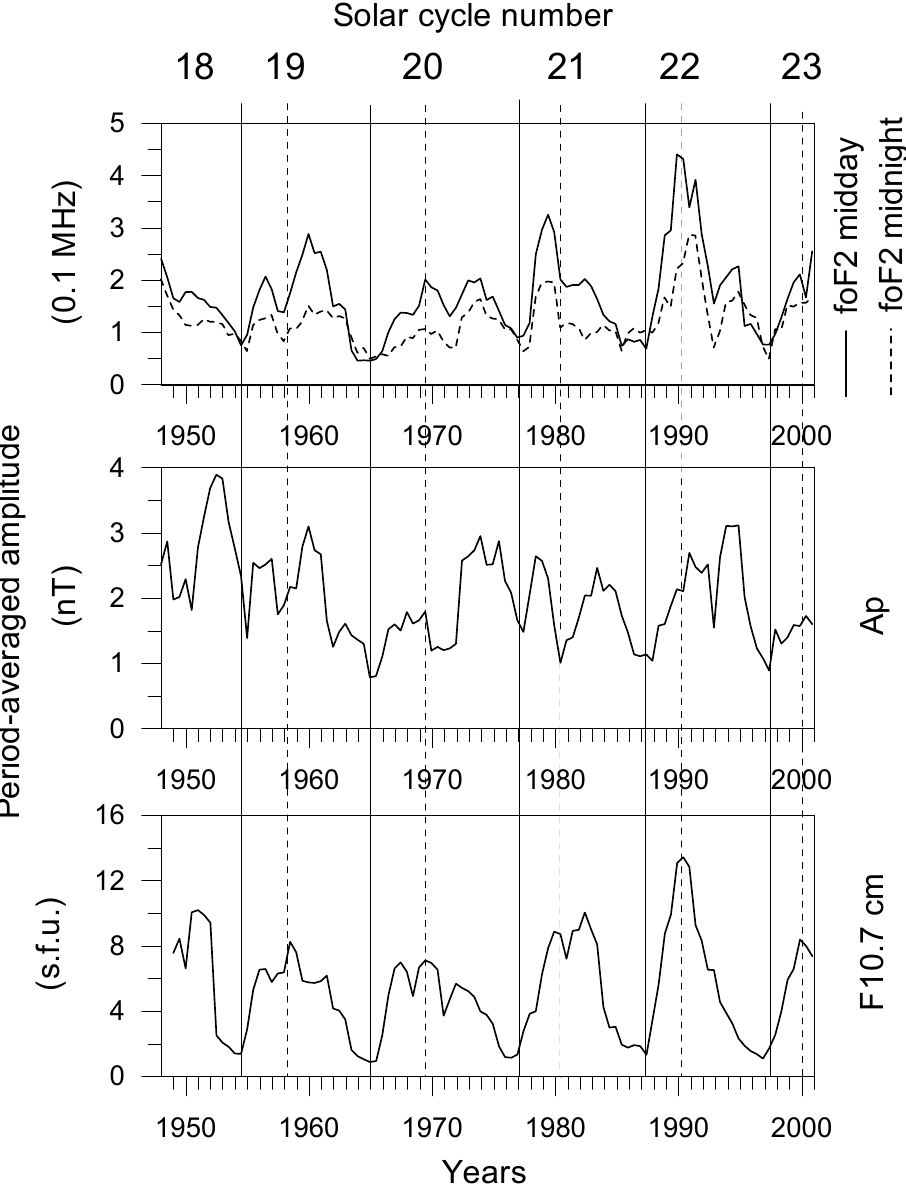
Fig. 3. Behaviour of the period averaged amplitude of the period band 25–31 days for fo F2 (Moscow) for midday and midnight, A p and F10.7 cm for the interval 1947–2001. The solar cycle maxima and minima are marked as in Fig. 1.